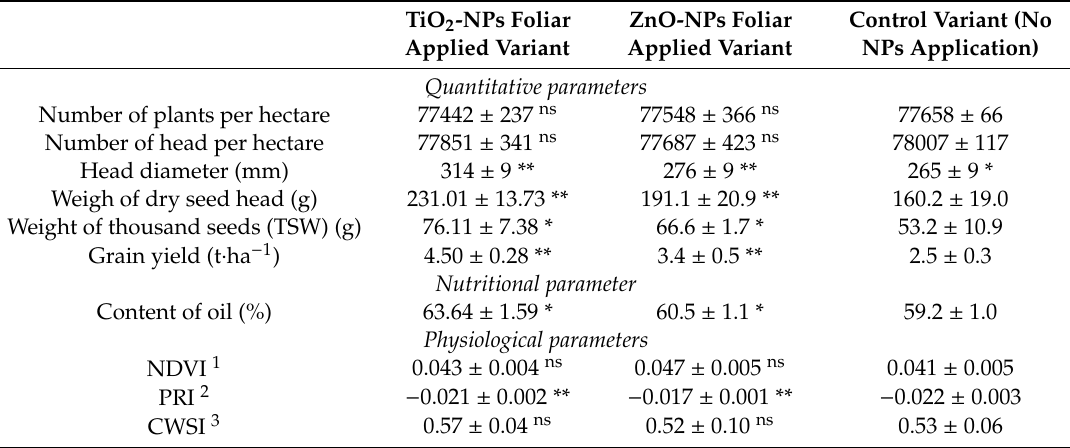
Table 7. List of TiO 2 -NPs- and ZnO-NPs-treated sunflower plant quantitative, nutritional and physiological parameters, and those for the control. Plants were harvested after 125 days. Results show standard deviation and Fisher’s least significant di ff